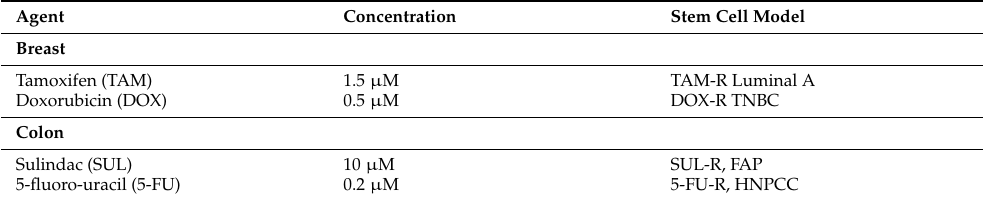
Table 4. Drug-resistant stem cell